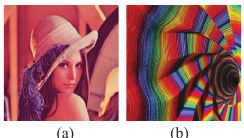
Figure 9. Two secret images: ( a ) SI 1 : 256-color Lena ( b ) SI 2 : true color Kaleidoscope.